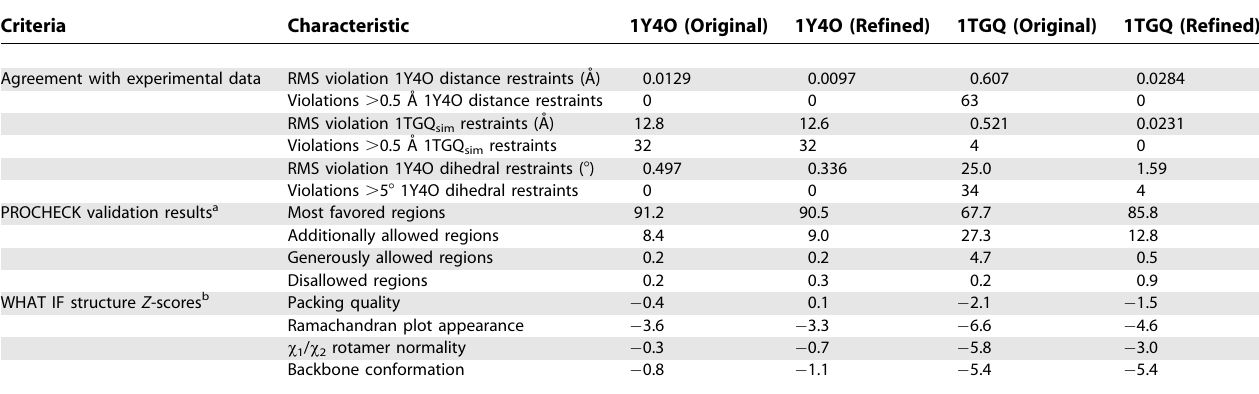
Table 1. Average Quality Indicators of the 1Y4O and 1TGQ Structure Ensembles before and after Refinement in Explicit Solvent Criteria Characteristic Agreement with experimental